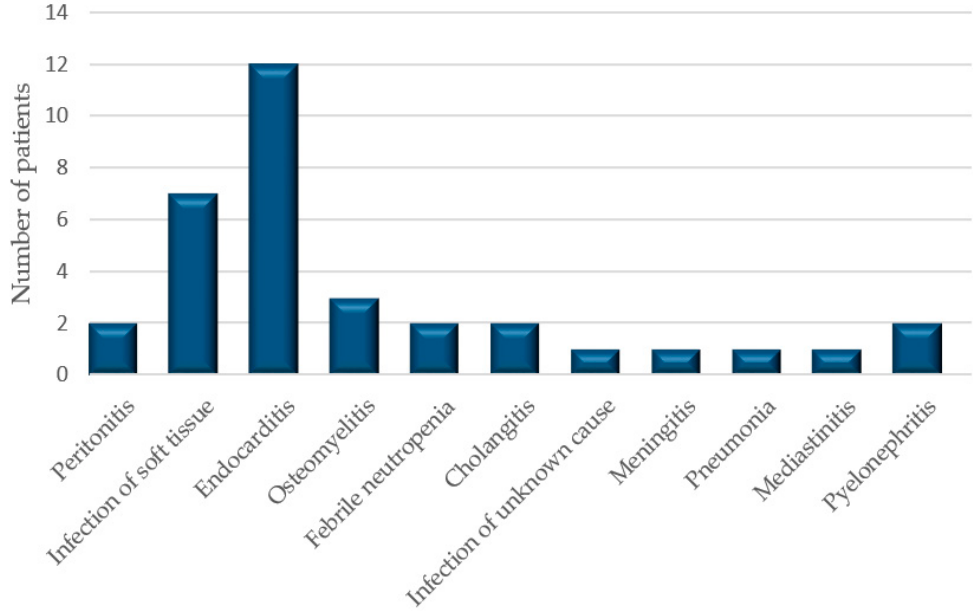
Figure 1. The diagnoses of patients.